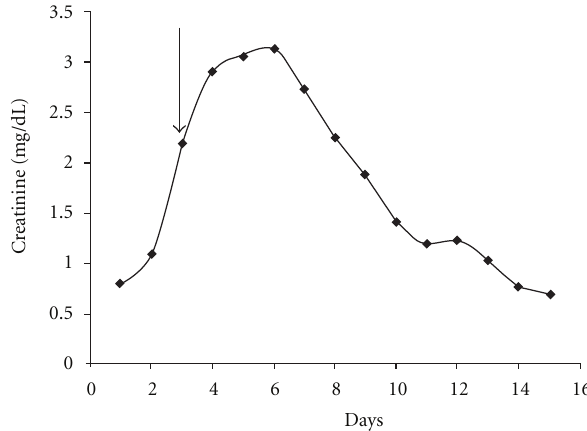
Figure 2: The x -axis is time (days) and the y -axis serum creatinine values in mg/dL. Elevation of serum creatinine was seen at the time of admission (arrow) which peaked and then gradually returned to baseline after successful thrombolysis, angioplasty, and stent placement.